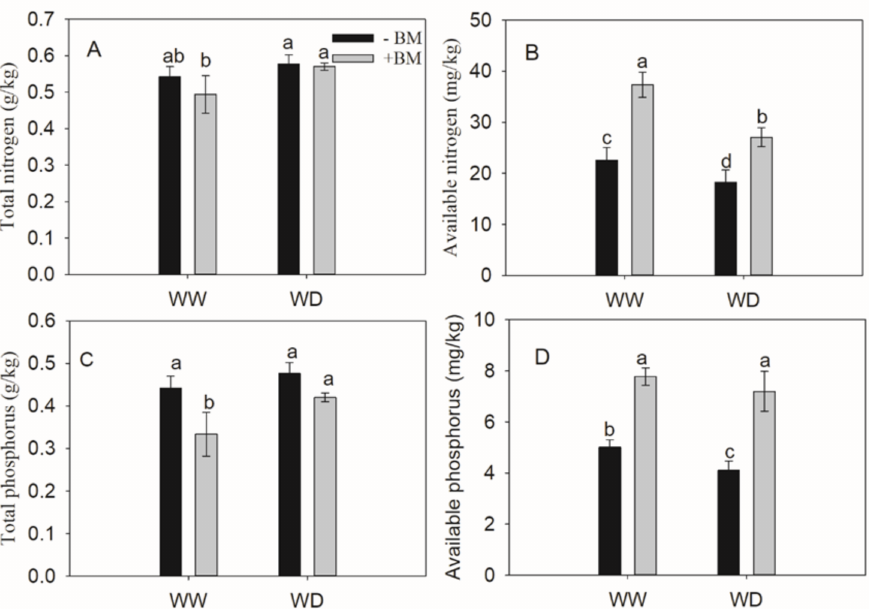
Figure 8. Effect of BM application on total nitrogen ( A ), total phosphorus ( B ), available nitrogen ( C ) and available phosphorus in the soil ( D ) under two water statuses. WW and WD showed the different soil water contents. The different letters indicate significant difference ( p < 0.05).